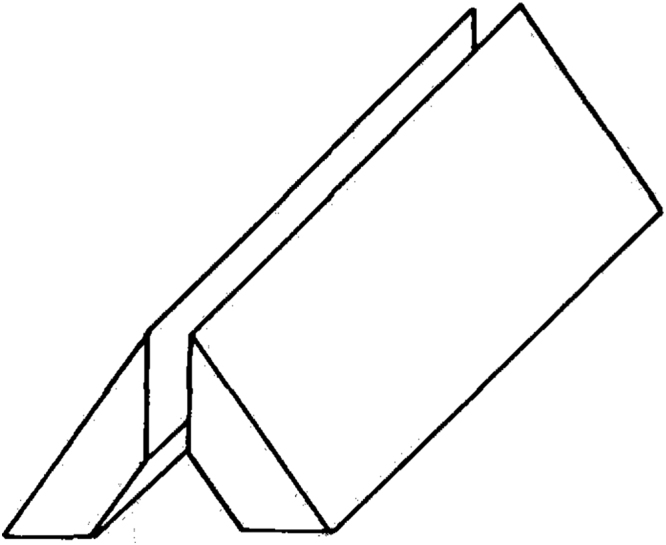
Naphthalene plates.